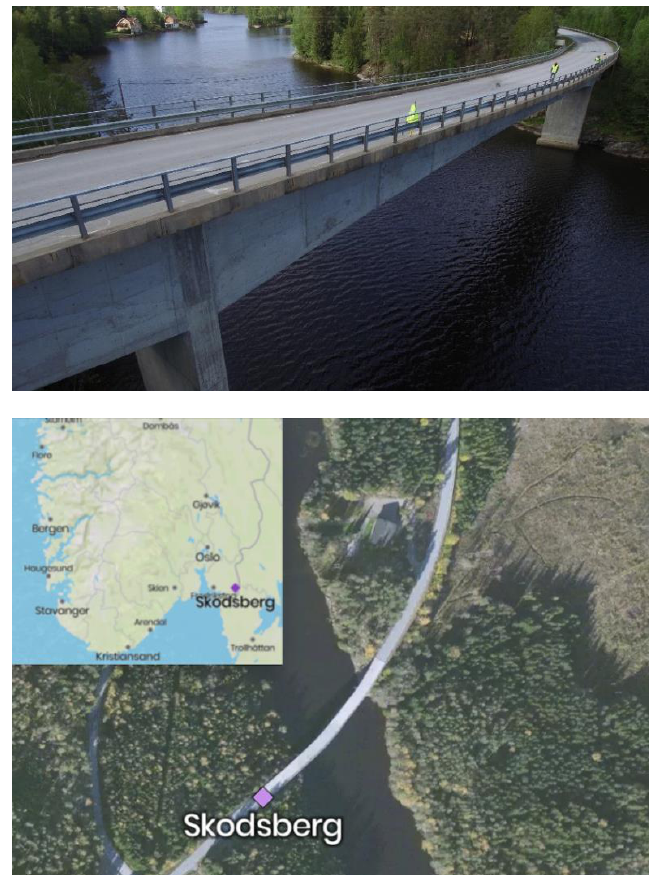
Figure 2. Skodsberg Bridge overall view and key bridge data.